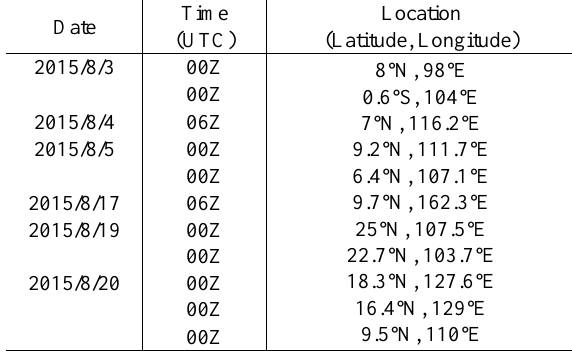
Table 1. Identified overshooting top cases by Himawari-8 images, CloudSat/CALIPSO data and NWP tropopause temperature with visual interpretation.